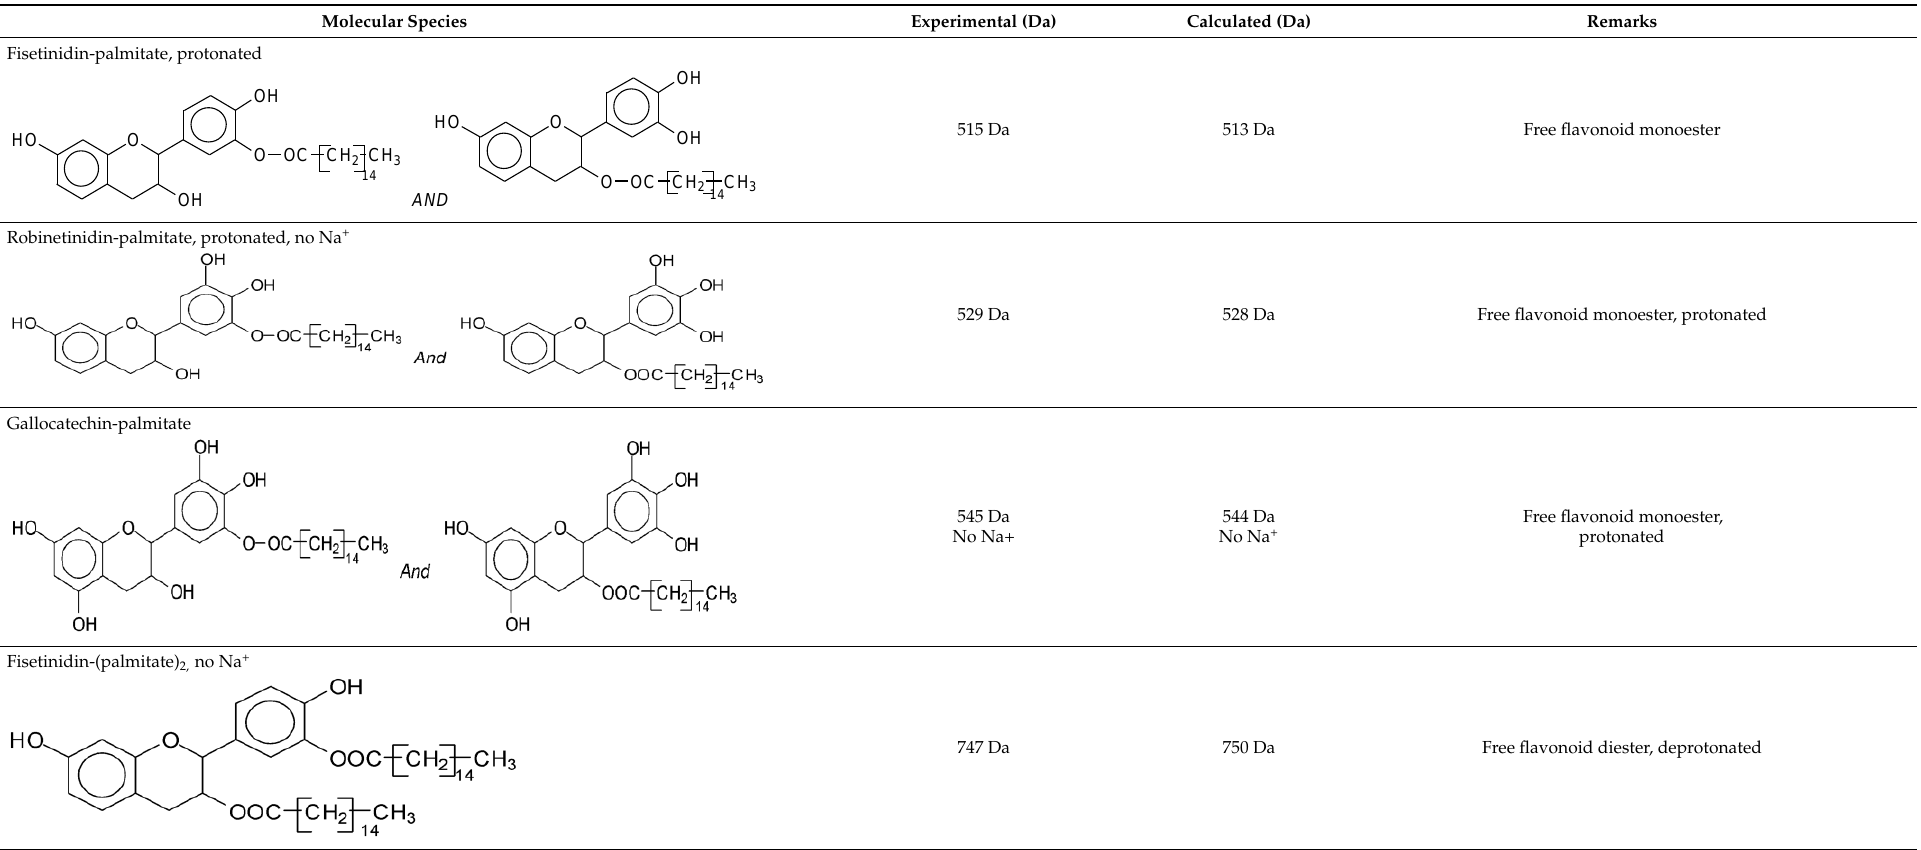
Figure 5. Example of the structures of two possible isomers of the identified species glucose- (fisetinidin) 2 -(palmitate) 3 at 1442 Da. Table 4. Characterization by MALDI-TOF of oil-grafted tannins using palmitoyl chloride. Molecular Species